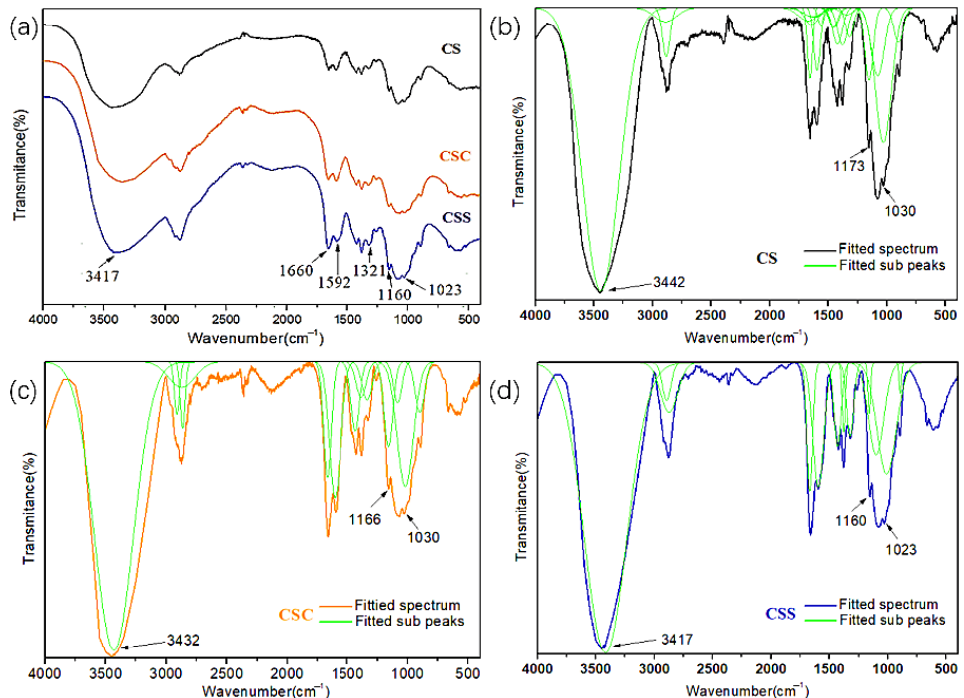
Figure 5. FT-IR spectra of chitosan ( a ) and fitted FT-IR spectra of CS ( b ), CSC ( c ), CSS ( d ).